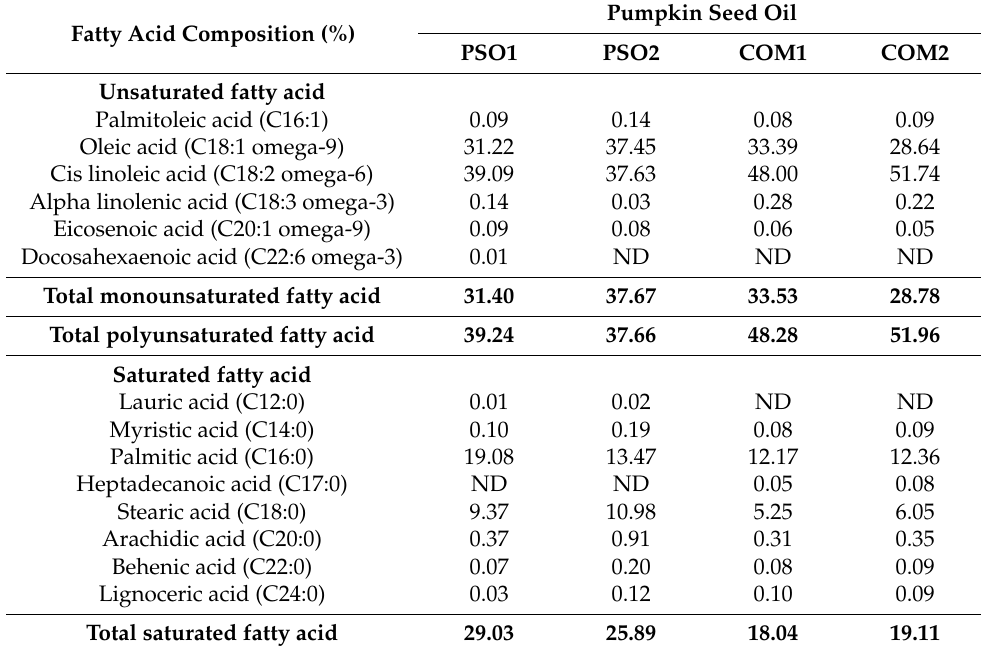
Table 1. Fatty acid compositions in pumpkin seed oil